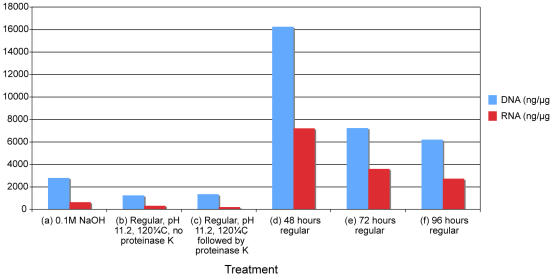
DNA and RNA yields (ng/µg original tissue) in six different nucleic acid extracts from sample PM85L.Each extract derives from a different digestion technique (a–f). For full details of the digestion protocols refer to main text. The data clearly demonstrates that total (but not necessarily amplifiable) DNA and RNA yields are greatly reduced in extracts performed using hot alkali techniques [22], [23].